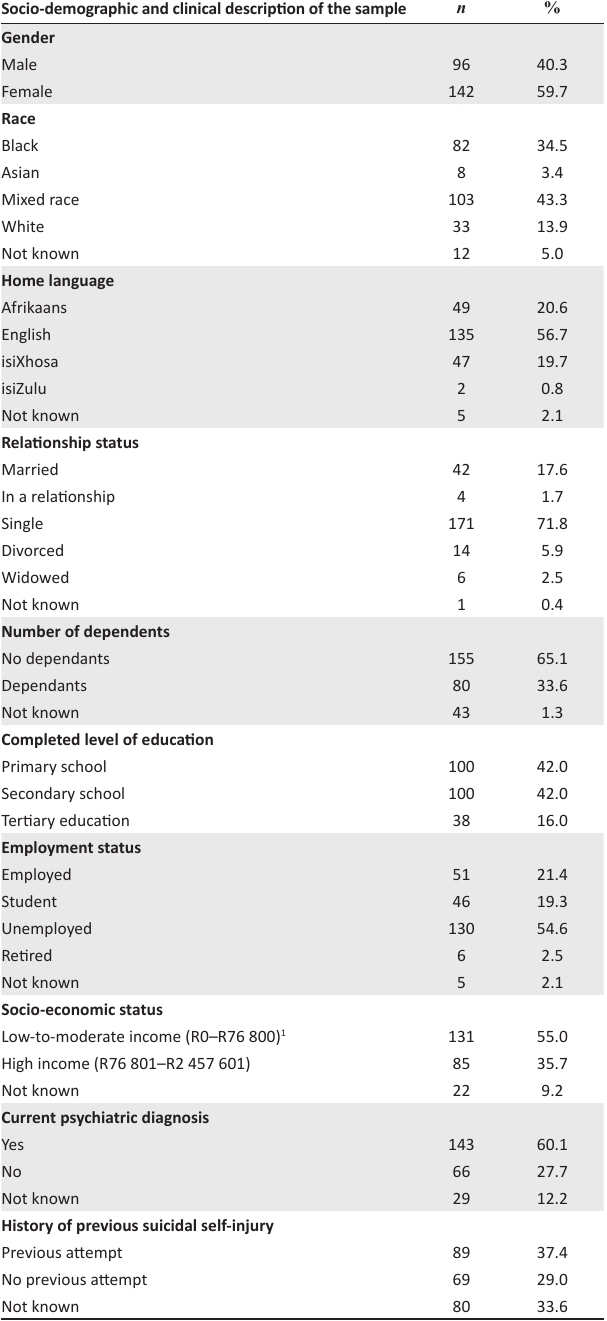
TABLE 1: Description of sample and method of self-harm ( N = 238). Socio-demographic and clinical description of the sample